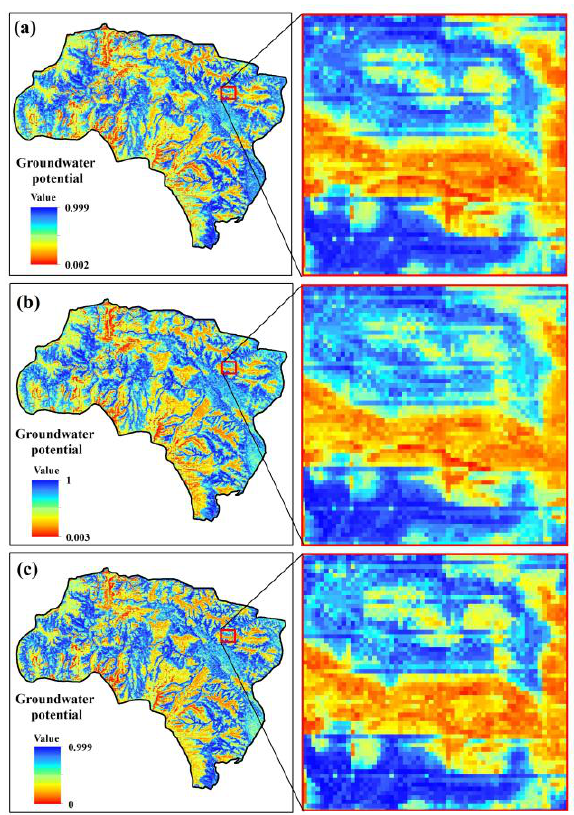
Figure 7. Groundwater potential maps produced by RF and three sample datasets ( a – c ).